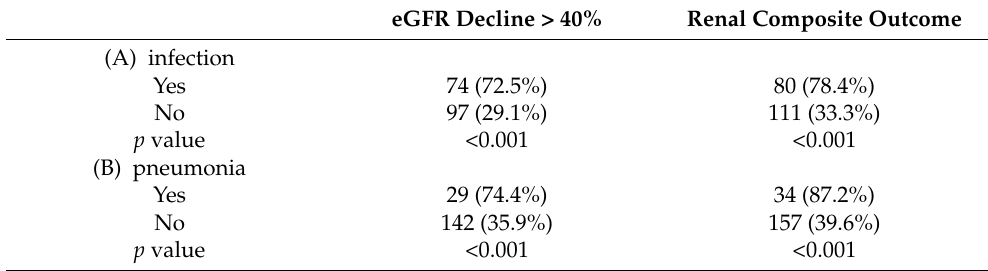
Table 2. Comparisons of study outcomes by the presence/absence of infection and pneumonia.